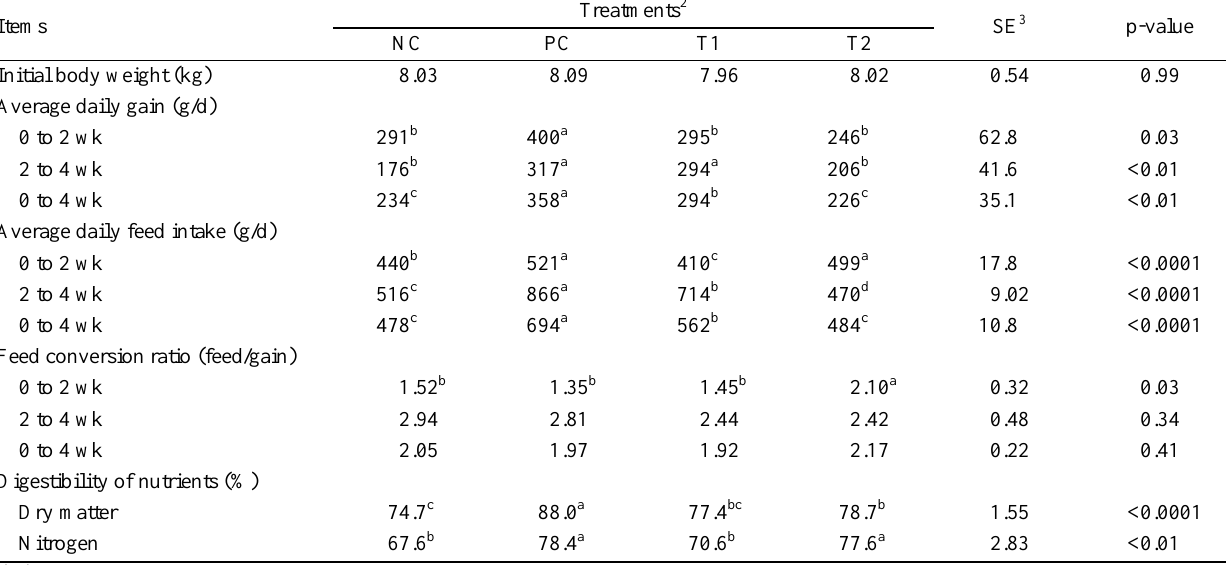
Table 2. Effects of resveratrol and essential oils blend on growth performance and nutrient digestibility of challenged piglets 1